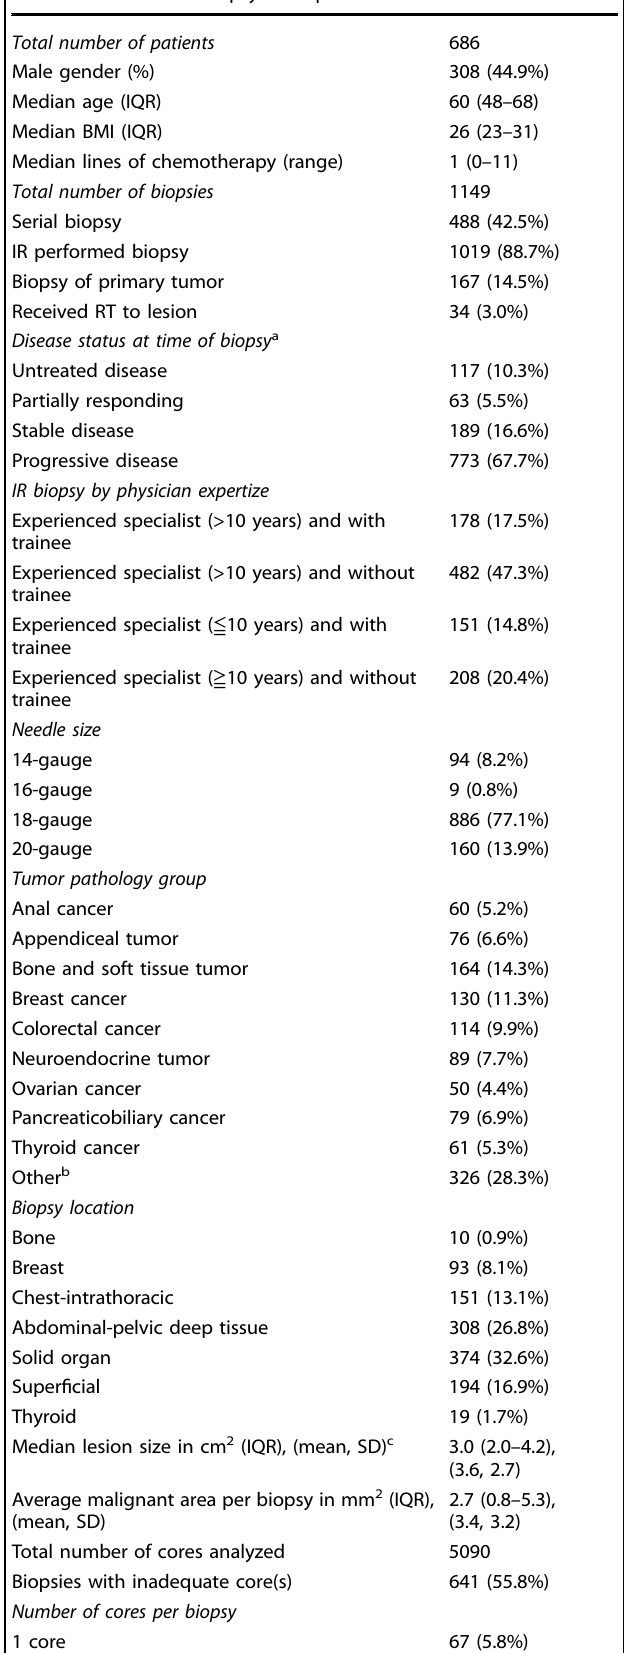
Table 1. Patient and biopsy